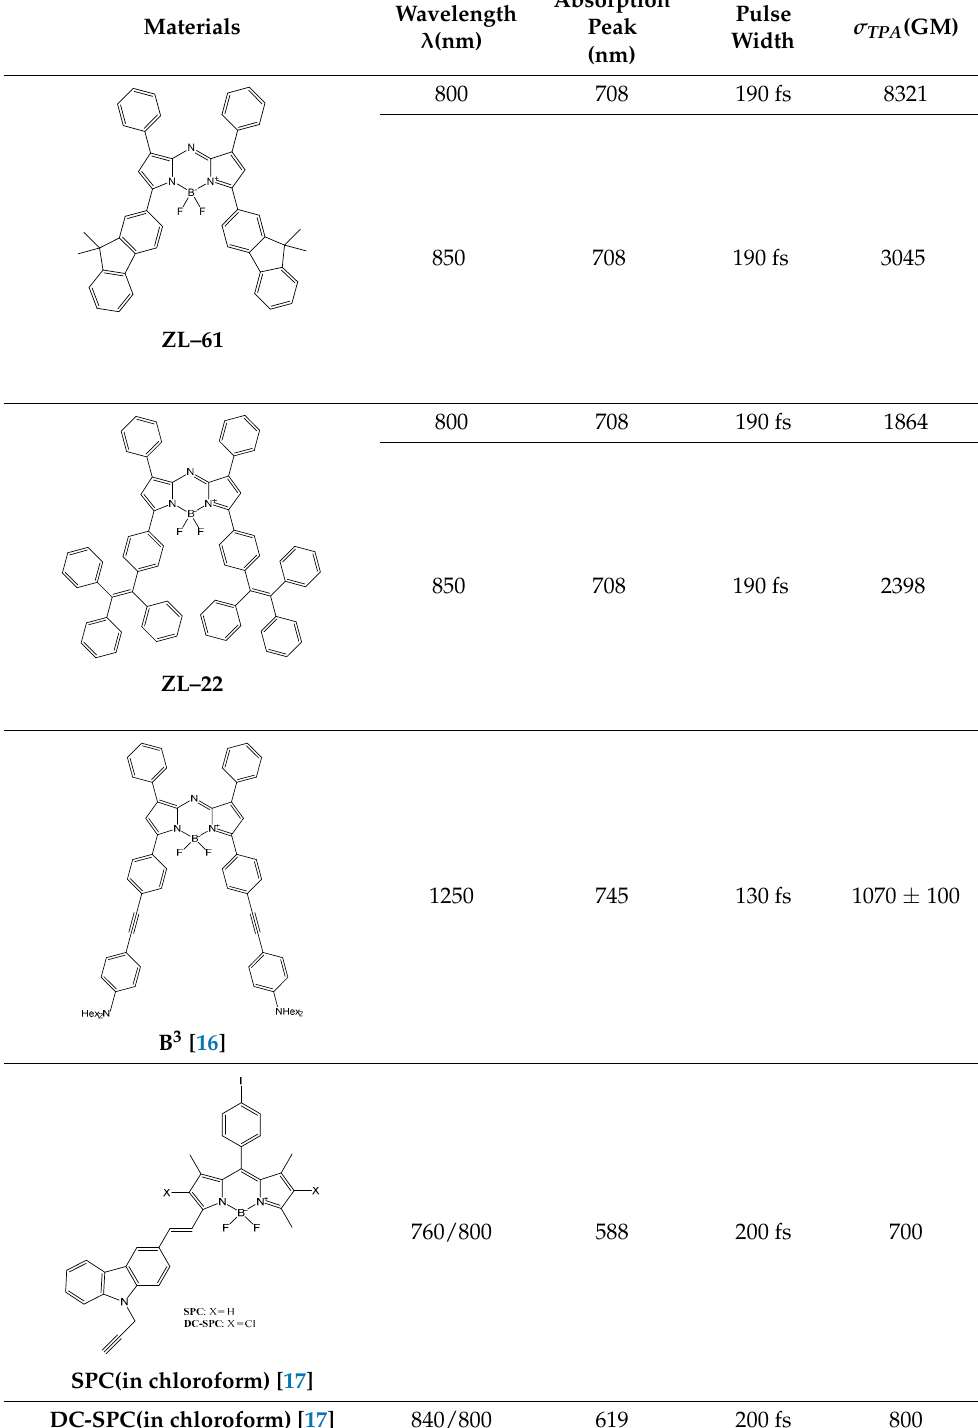
Table 3. Summary of the TPA cross sections of ZL-61, ZL-62, and other representative BODIPY derivatives in the near-infrared regime.